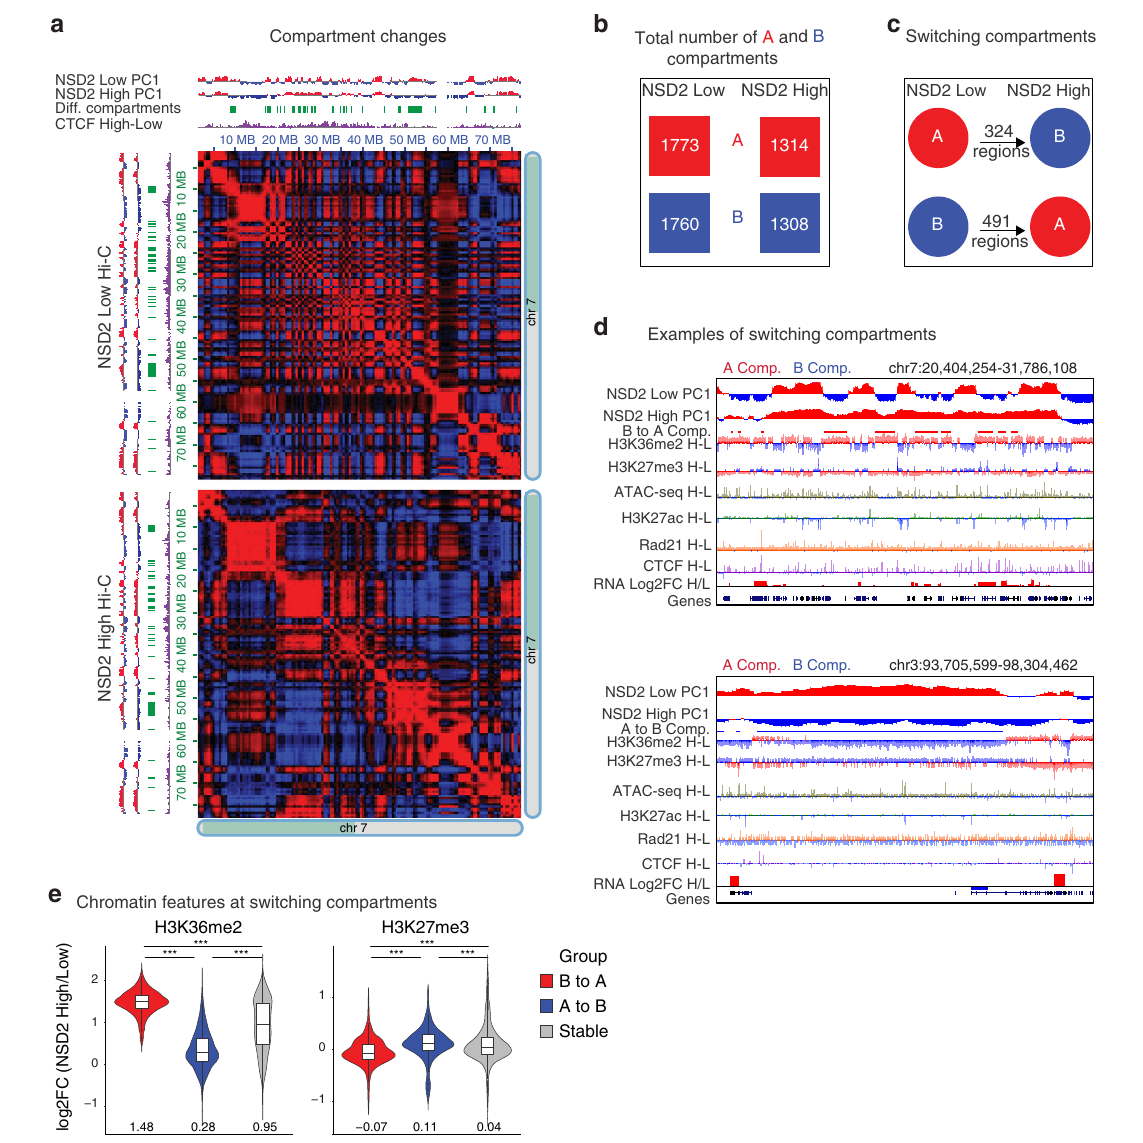
Fig. 3 NSD2 overexpression drives A/B compartment switching. a Compartment weakening for half of chromosome 7 is shown in NSD2 High versus Low cells. Top and left: Eigen vector (PC1) for compartments A and B in red and blue, respectively. Switching regions are shown in green and in purple the subtraction of CTCF signal (NSD2 High – Low). Heatmaps represent the Pearson correlation of interactions in NSD2 Low (top) and High (bottom) cells. Positive and negative Pearson correlations between two loci are represented in red and blue, respectively. b Total number of A (red) and B (blue) compartments in NSD2 High versus Low cells. c Number of regions that switch compartments from B to A in (491 regions) or A to B (324 regions) in NSD2 High versus Low cells. d IGV screenshots show examples of regions that switch from A to B (top panel) and B to A (bottom panel) in NSD2 High versus Low cells. Eigen vectors (PC1), differential compartment switching, subtraction tracks of H3K36me2 and H3K27ac and expression for NSD2 High and Low cells are shown. Regions that signi fi cantly switch from B to A and from A to B are indicated in red (top panel, B to A) or in blue (bottom panel, A to B), respectively. H – L refers to subtraction of the ChIP-seq signal (NSD2 High – Low). e Changes in H3K36me2 and H3K27me3 levels within regions that switch compartment from B to A (red), A to B (blue), or are stable (gray) in NSD2 High cells. Log2-fold changes (NSD2 High versus Low cells) for H3K36me2 and H3K27me3 are shown. The median is indicated under the violins. Source data are provided as a Source Data fi